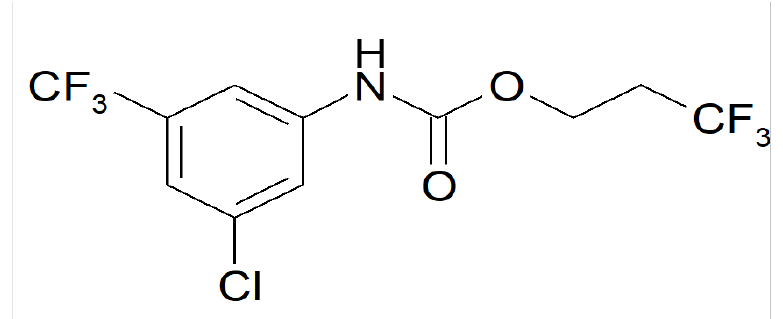
Figure 1. Molecular structure of the ETG-5773 compound.